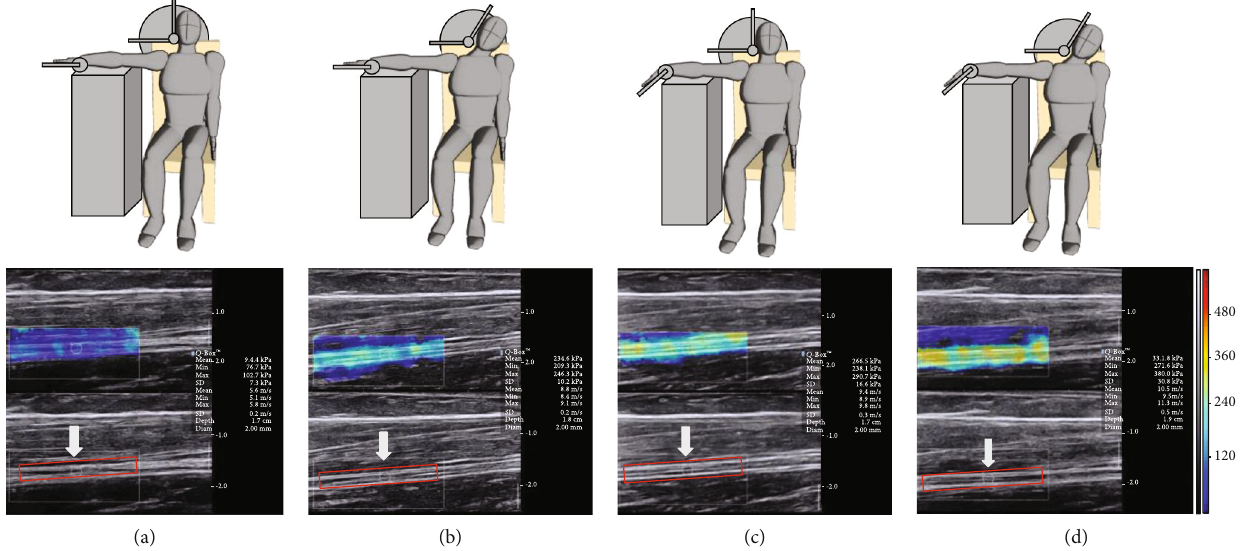
Figure 1: Schematic diagram of upper limb neurodynamic testing. Images of the median nerve between the super fi cial fl exor and the deep fl exor at the midpoint of the forearm which is sampled and measured; the color area of the image is the elastic image area of shear wave and the measured area neutral posture (a); contralateral cervical fl exion (b); wrist extension (c); and contralateral cervical fl exion+wrist extension (d). Table 1: Intra- and interoperator reliabilities of SWE for assessing the shear modulus of the median nerve.